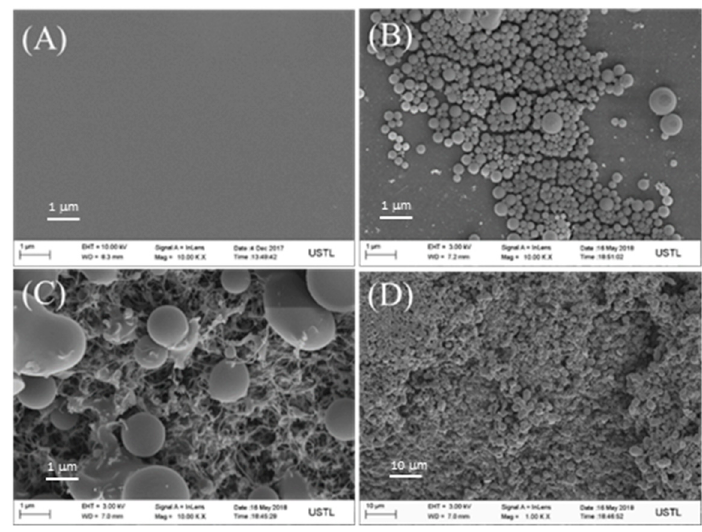
Figure 1. SEM images of polyimide (PI)/ glassy carbon electrode (GCE) ( A ), carbon black (CB)/PI/GCE ( B ), and CB-carbon nanotube (CNT)/PI/GCE ( C , D ).